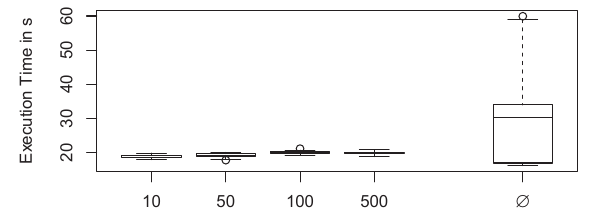
Figure 4: Execution times of the Wnt/ β -catenin pathway model with the adaptive simulator using the changed AVQ with m ∈ { 10 , 50 , 100 , 500 } compared to the execution times of the avail- able 24 non-adaptive simulator